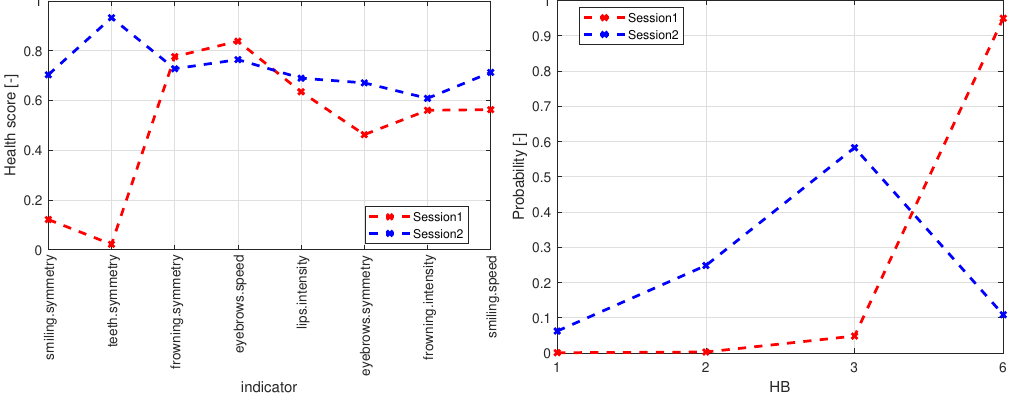
( b ) Probabilities of HB grades predicted by OLR model for the typical patient. The classification by a clinician for Session 1 was HB6 and for Session 2 HB3.